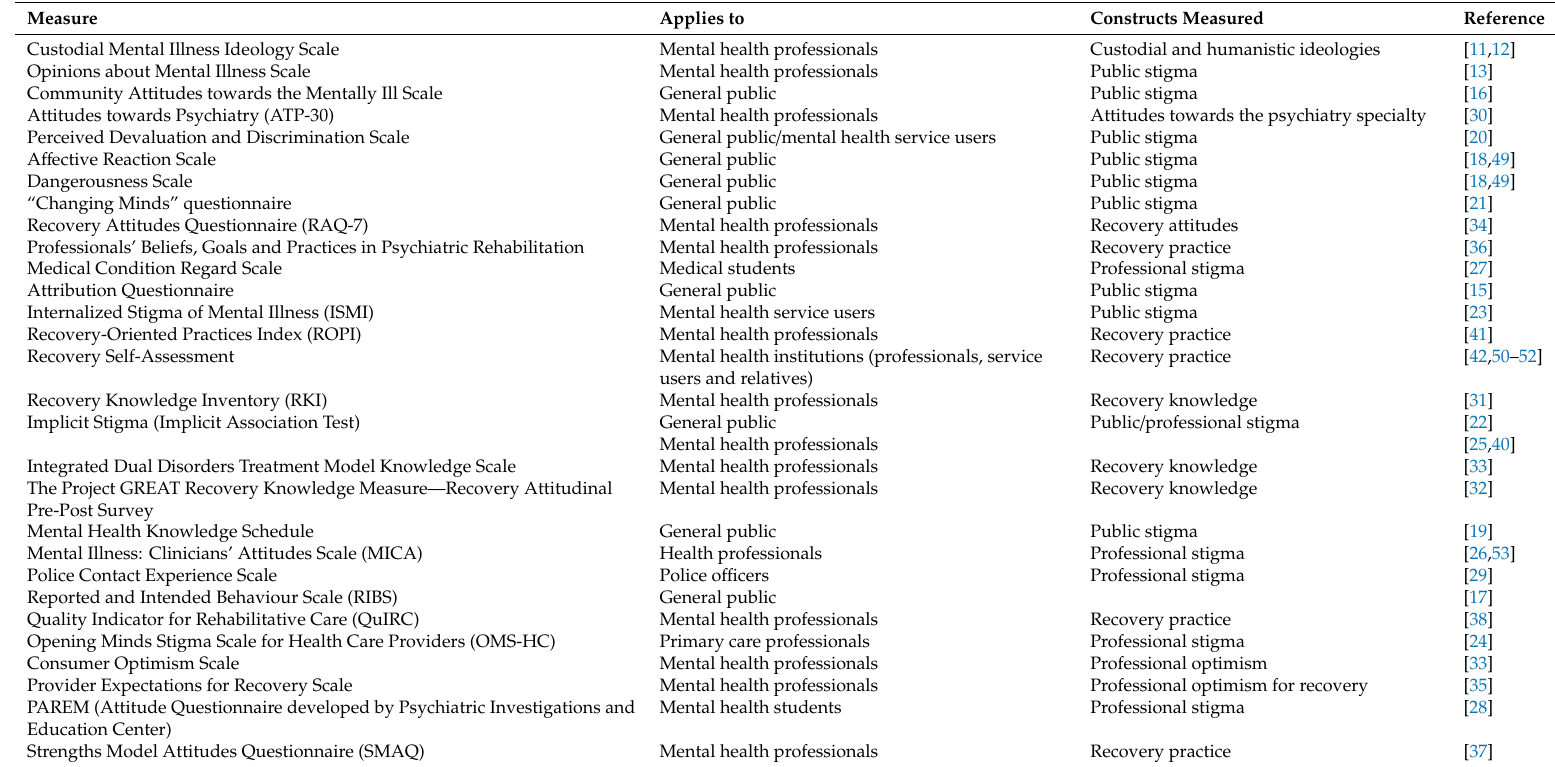
Table 1. Previous measures of mental health professionals’ beliefs and attitudes towards service users’